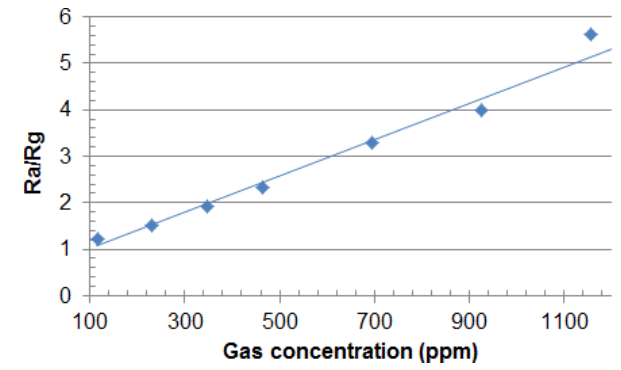
Figure 10. Dependence of response and recovery times of MWCNTs/SnO 2 PG vapor sensor on gas concentration measured at 200 ◦ C operating